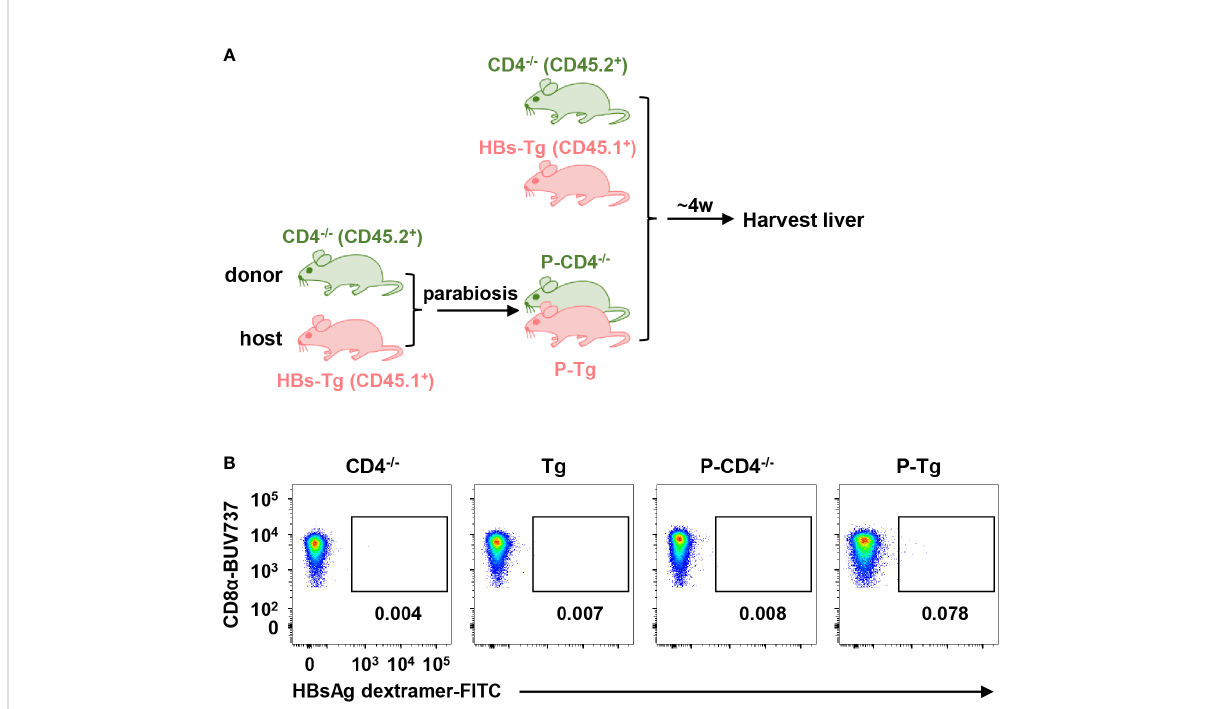
FIGURE 6 Donor HBsAg-speci fi c CD8 + T cells could not be elicited in the HBs-Tg parabionts paired with CD4 -/- mice. HBs-Tg mice (CD45.1 + ) were surgically conjoined with CD4 -/- mice (CD45.2 + ) to generate CD4 -/- -HBs-Tg parabiotic mice. Four weeks after surgery, parabiotic mice were separated and liver samples were harvested from each group. Intrahepatic MNCs were isolated for fl ow cytometry analysis. (A) Protocol for the model of CD4 -/- -HBs-Tg parabiotic mice (schematic). (B) Representative plots showing the frequency of HBsAg dextramer + CD8 + T cells in the liver of each group. CD4 -/- , CD4 -/- control; Tg, HBs-Tg control; P-CD4 -/- , CD4 -/- parabiont; P-Tg, HBs-Tg